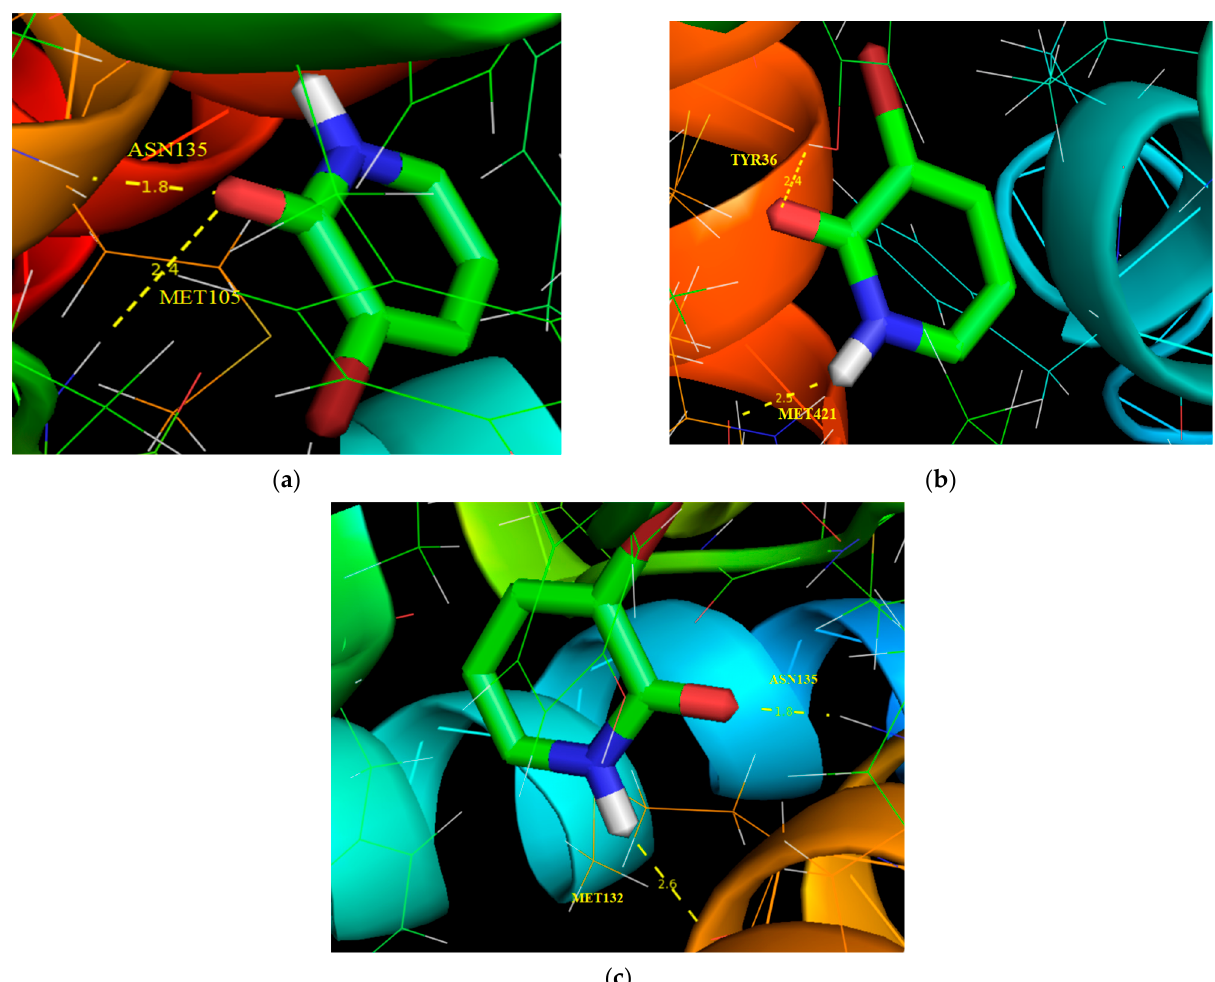
Figure 10. Molecular docking and hydrogen bond interactions of 3-Br-2-HyP with ( a ) 5IBN, ( b ) 3U5K and ( c ) 6CD5 with protein structure. Table 7. Hydrogen bonding and molecular docking with protein targets.